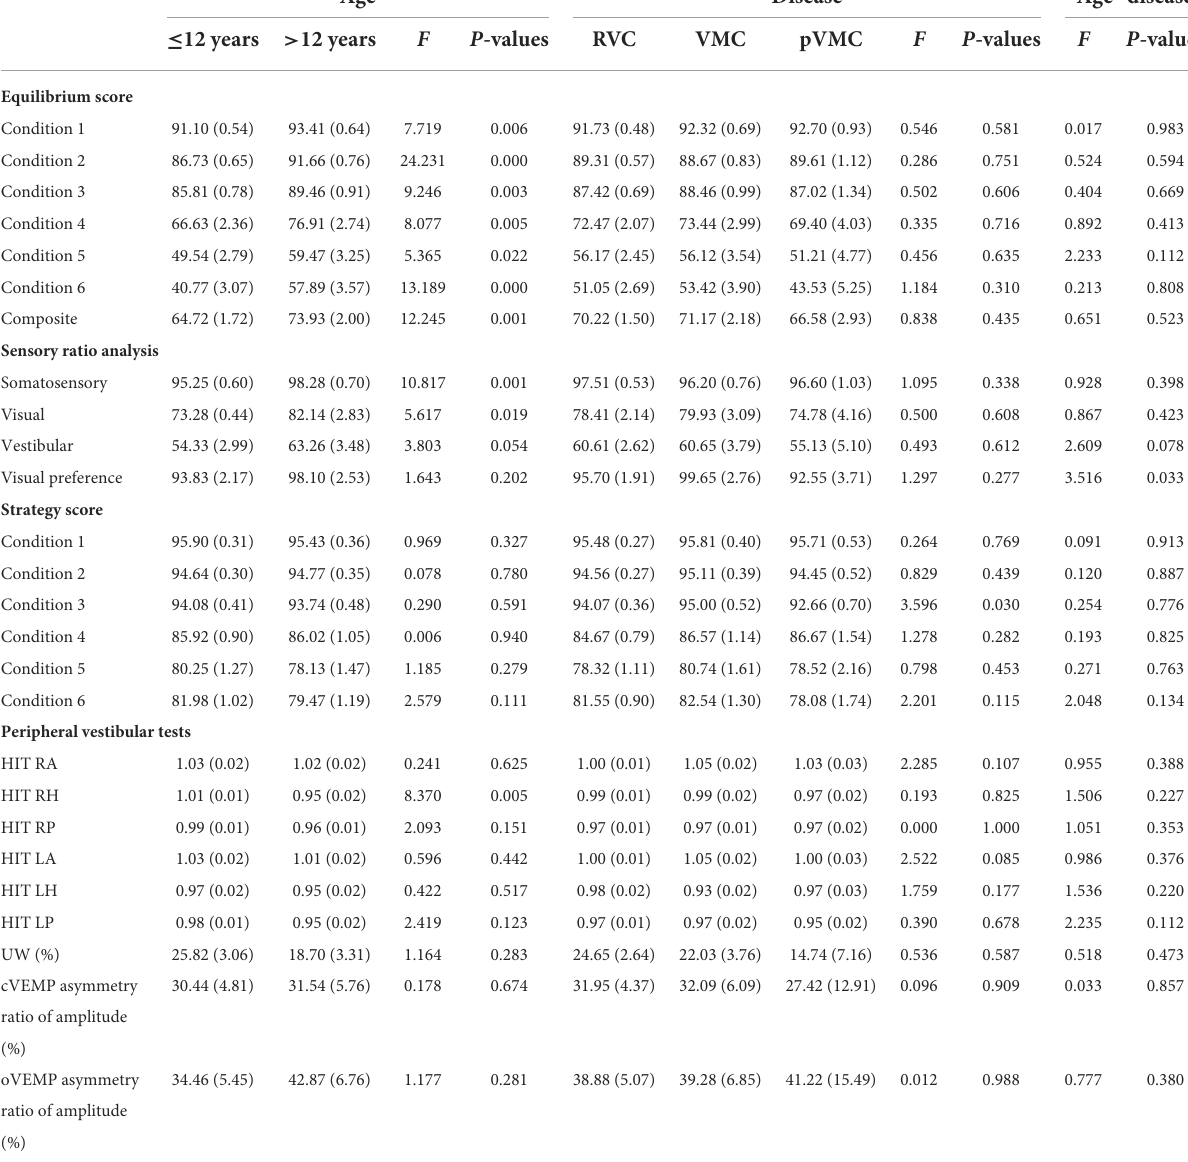
TABLE 3 Tests of between-subject effects of